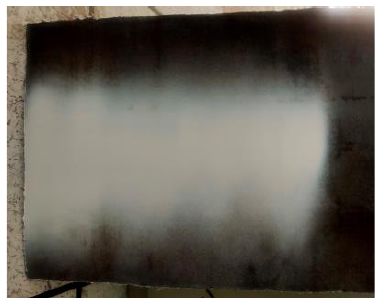
Figure 19. Plane dynamic spraying coating film.